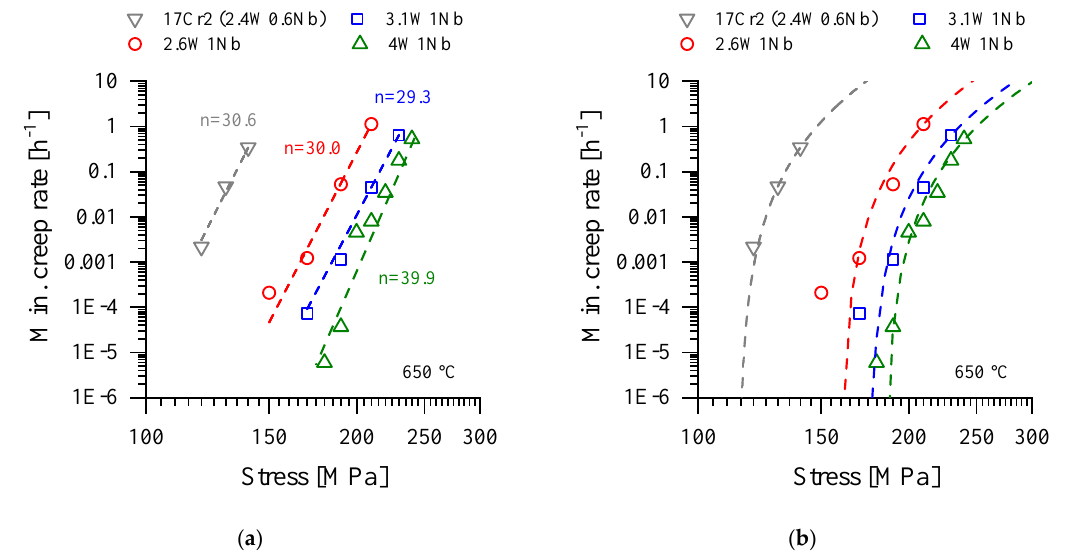
Figure 6. Data of the trial steels and the 17Cr2 base alloy. Fitted by ( a ) the Norton–Bailey relation [20,21] and ( b ) a modified Mukherjee–Bird–Dorn equation [23,24]. All specimens were precipitation treated prior to testing for 5 h at 650 °C (testing temperature: 650 °C).